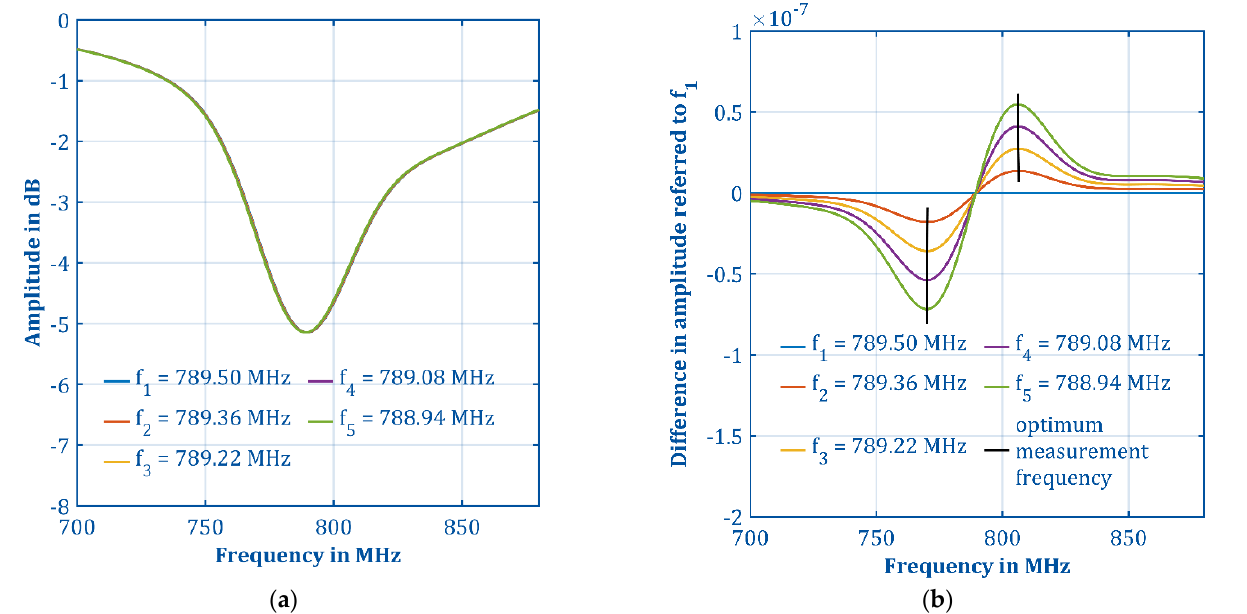
Figure 9. ( a ) Simulated frequency responses of CaSRR for different resonance frequencies (in 140 kHz steps). ( b ) Difference between the shifted frequency responses from the non-shifted frequency response, both including the impurity of the excitation source. The black lines mark the maximum differences in amplitude and thus the optimum excitation frequencies for the maximum sensitivity.